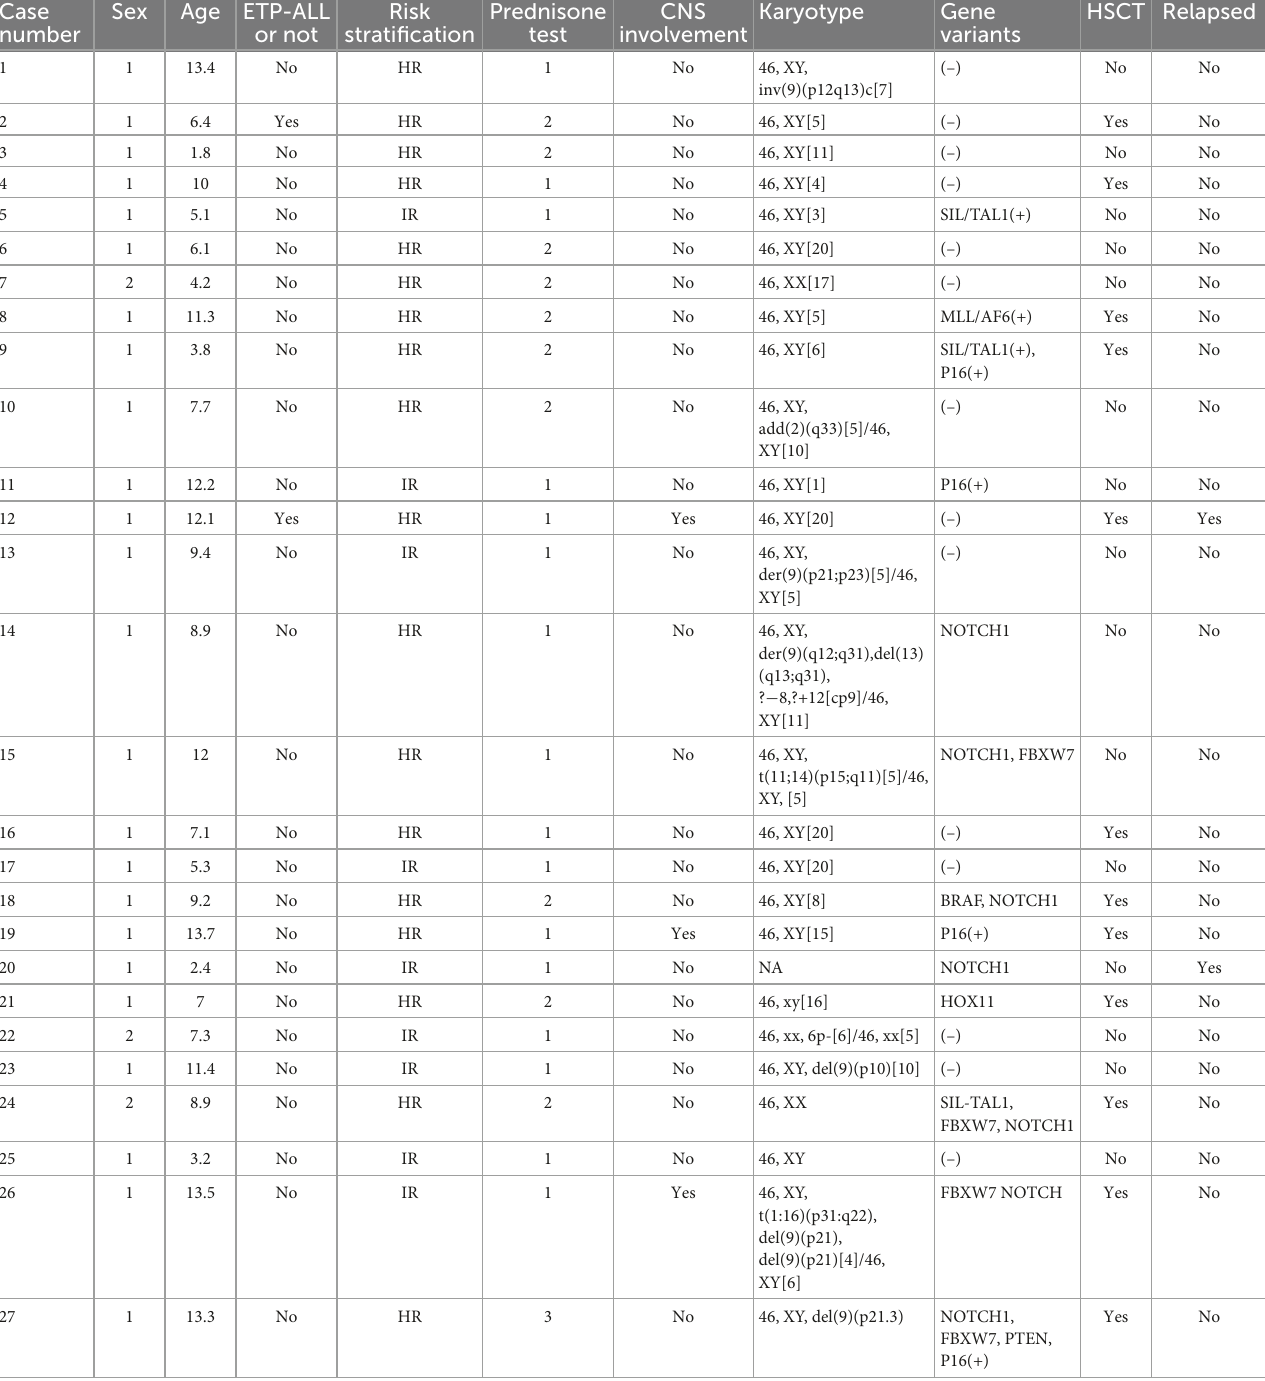
TABLE 1 Patient demographic and clinical